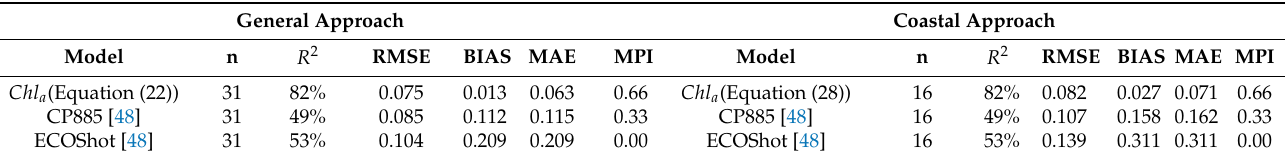
Table 8. Chl a general and coastal models compared with literature models.